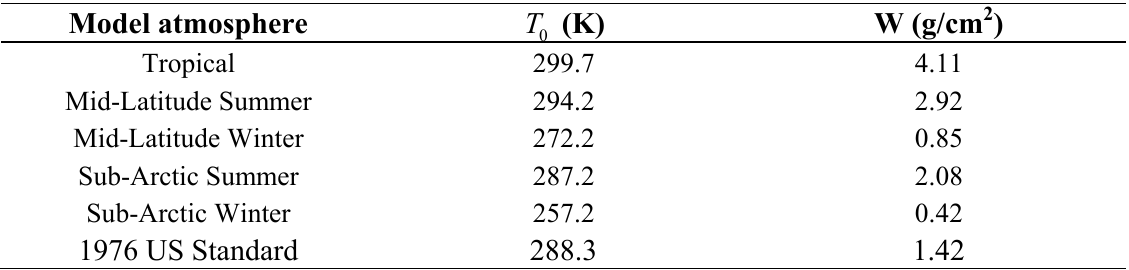
Table 3. Air temperatures at the first boundary and the total water vapor contents of the six standard model atmospheres prescribed in MODTRAN